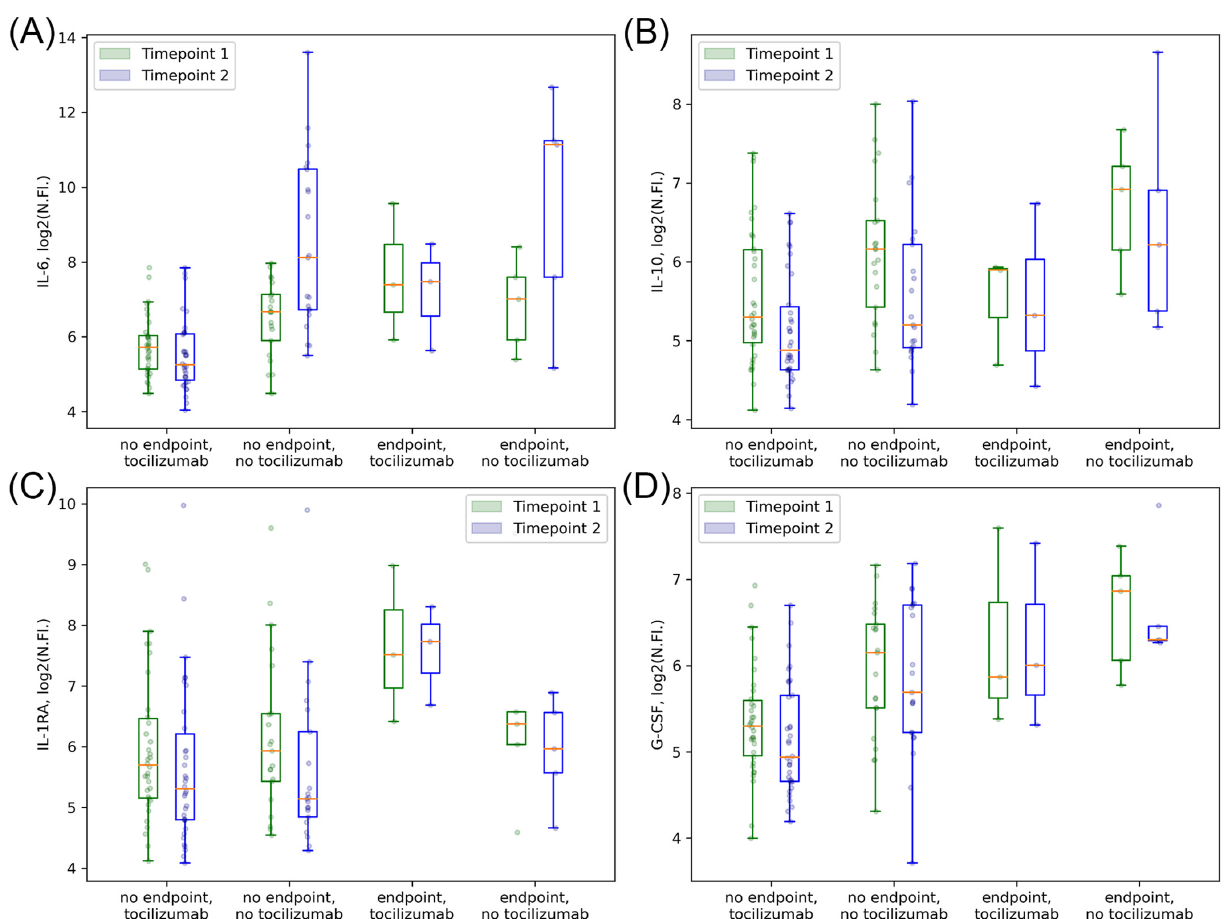
Figure 6. Boxplots for dynamic changes in four cytokines associated with clinical endpoints in patients with tocilizumab. IL–6 ( A ). IL-10 ( B ). IL-1RA ( C ). G-CSF ( D ). Data are presented as log2 of the normalized fluorescence values.